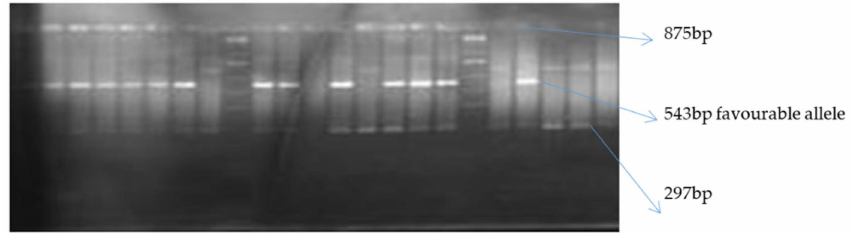
Figure 1. Gel image of crtRB1-3 (cid:48) TE PCR product resolved on a 2% agarose gel indicating polymor- phism of the marker for beta carotene allele.